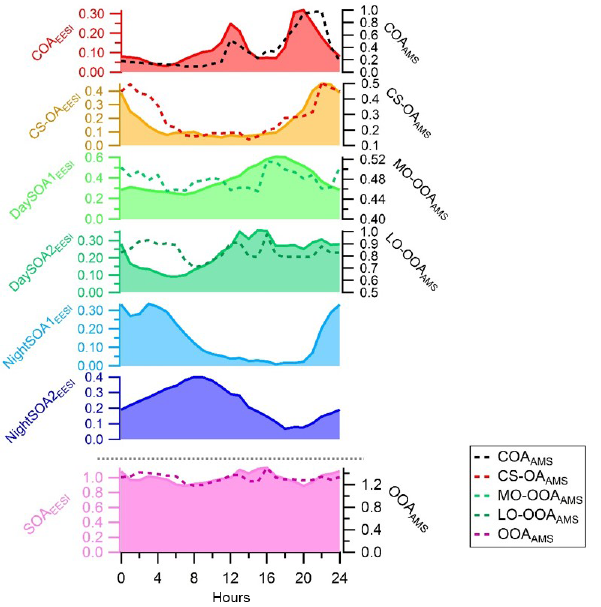
Figure 4. Diurnal variations in the EESI-TOF-MS PMF factors on the left axis (ags − 1 ) and counterpart diurnal variations from the AMS PMF analysis on the right axis (µgm − 3 ). The diurnal vari- ations are presented here for the entire measurement period (see Fig. S4 for the overlapping period only). SOA EESI and OOA AMS denote the sums of all the secondary